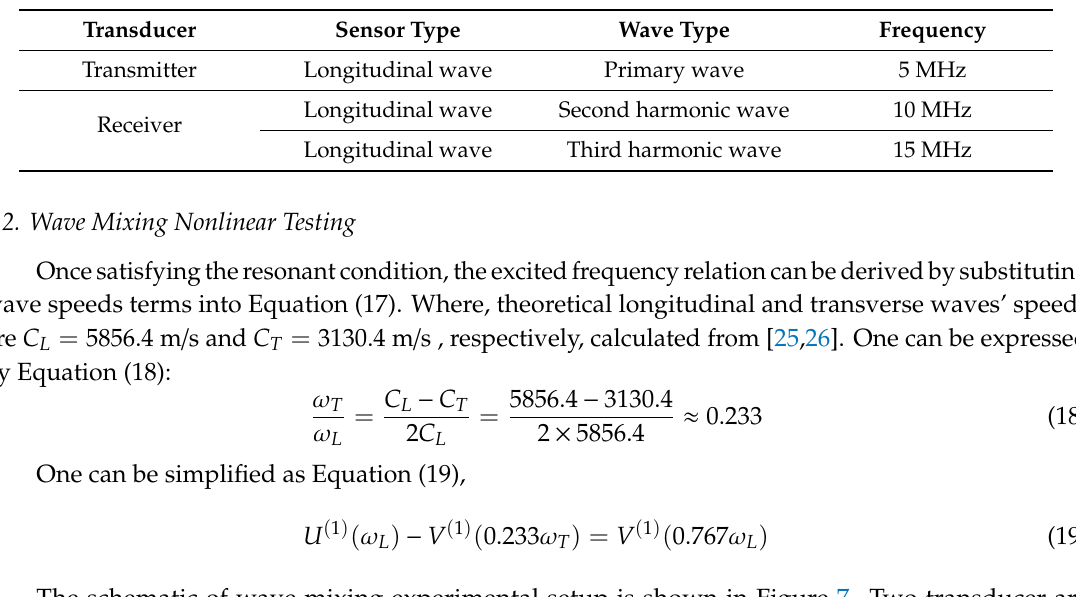
Table 2. Experimental conditions for higher harmonic measurement technique.